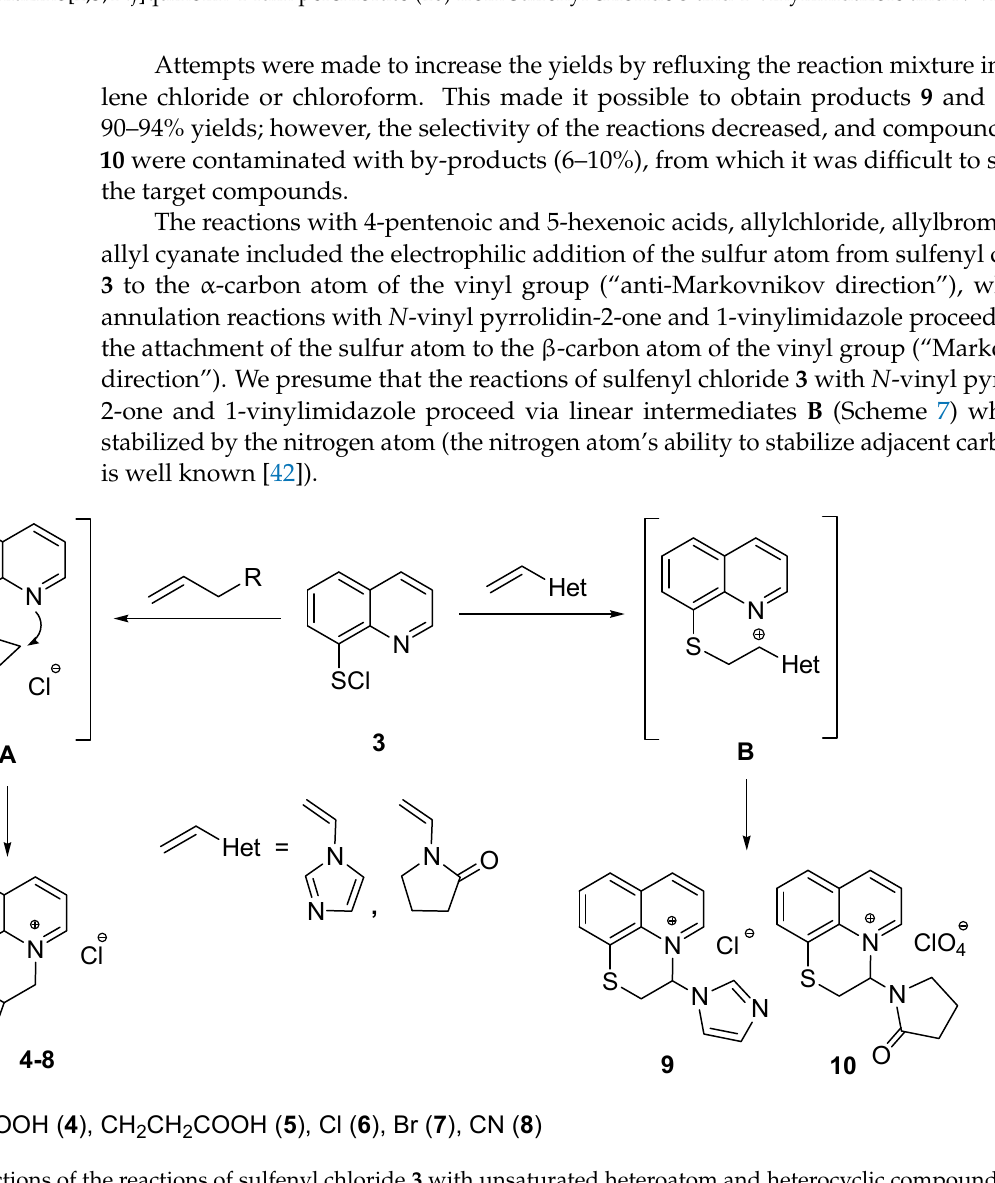
Scheme 7. Directions of the reactions of sulfenyl chloride 3 with unsaturated heteroatom and heterocyclic compounds.